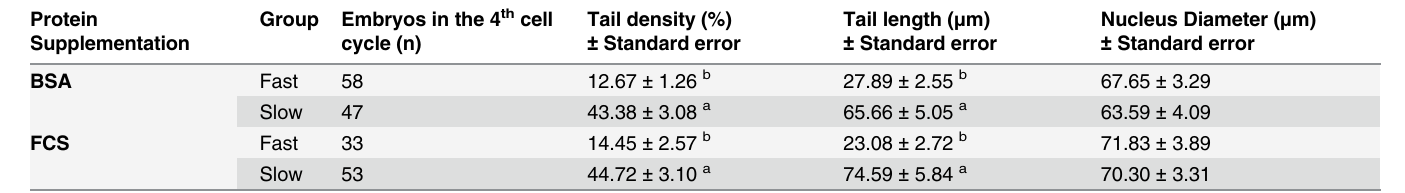
Table 6. Assessment of DNA fragmentation using the Comet assay (tail length and density) and nuclear diameter of the blastomeres of embryos in the fourth cell cycle classi fi ed according to the speed of development as Fast (at 48 hpi) or Slow (at 90 hpi) and cultured in media with different sources of protein.